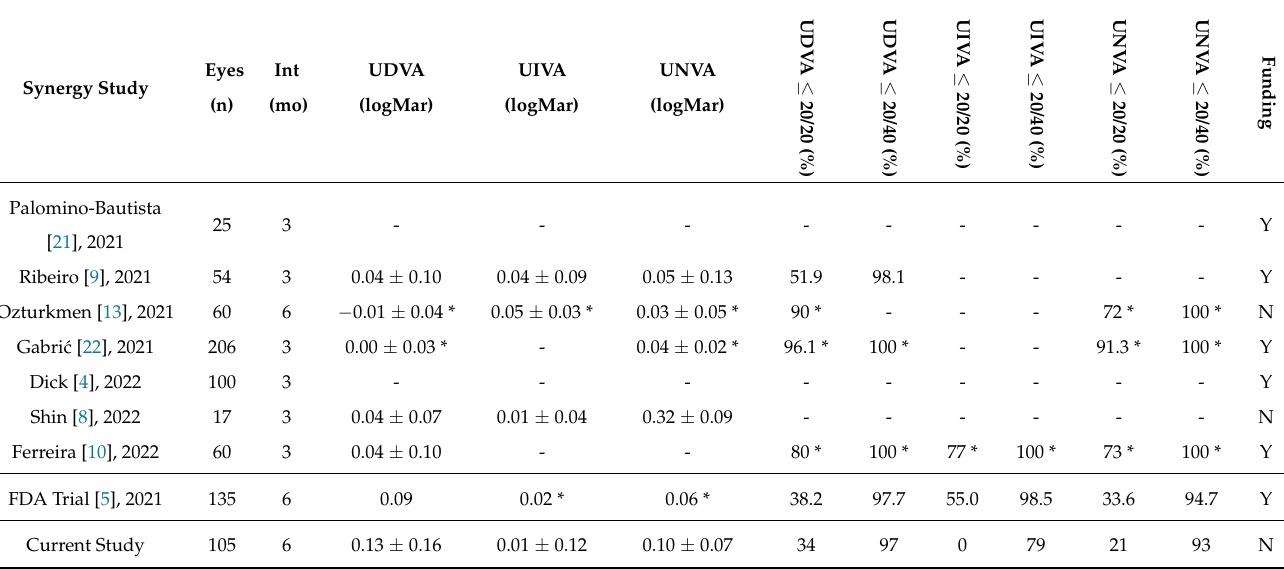
Table A1. Comparison of Synergy IOL Visual Outcomes in Published